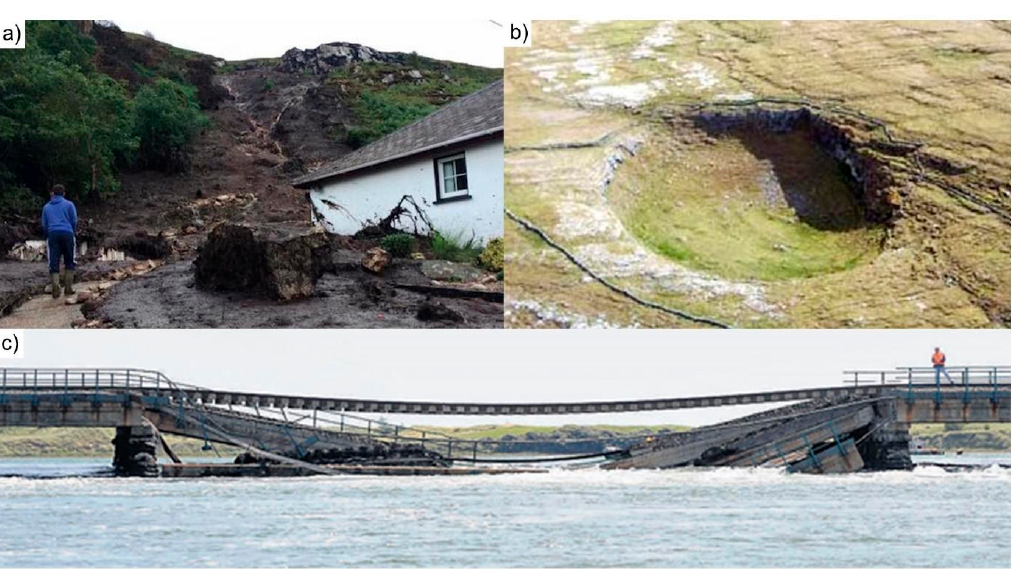
Figure 2. Examples of ground instabilities in Ireland. ( a ) mudslide in Urris, Co. Donegal that occurred in Aug. 2017 (Donegal Daily); ( b ) enclosed depression (Slieve Carran doline) in the Burren area, Co. Clare (David Drew); and ( c ) collapsed railway bridge at Malahide in north Co. Dublin (August 2009) (Irish Independent) resulting from tidally-influenced fluvial erosion. The locations of the ground instabilities are presented in Figure 3.